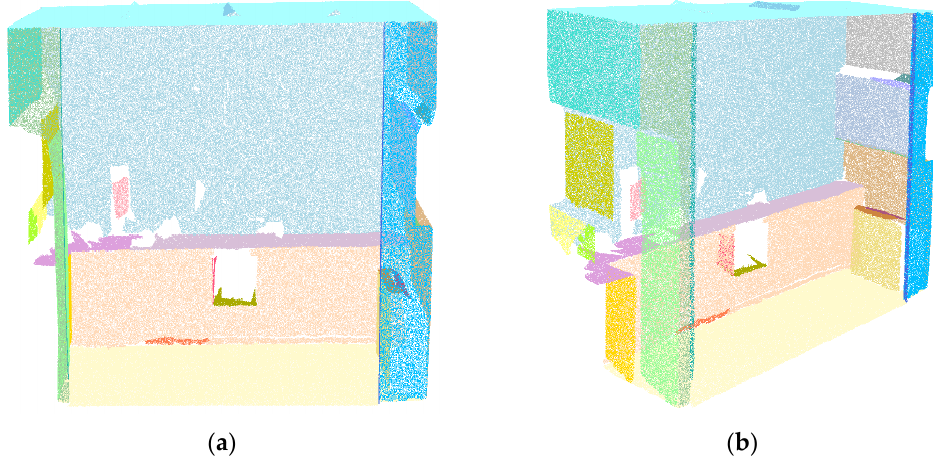
threshold: ( a ) front view and ( b ) top view.